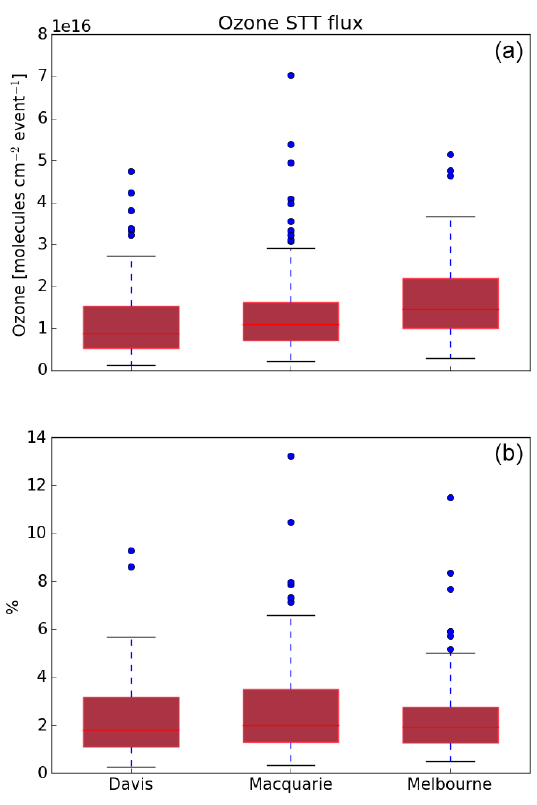
Figure 12. (a) Tropospheric ozone attributed to STT events. (b) Per- cent of total tropospheric column ozone attributed to STT events. Boxes show the interquartile range (IQR), with the centre line be- ing the median, whiskers show the minimum and maximum, and circles show values which lie more than 1.5 IQR from the median. Values calculated from ozonesonde measurements as described in the